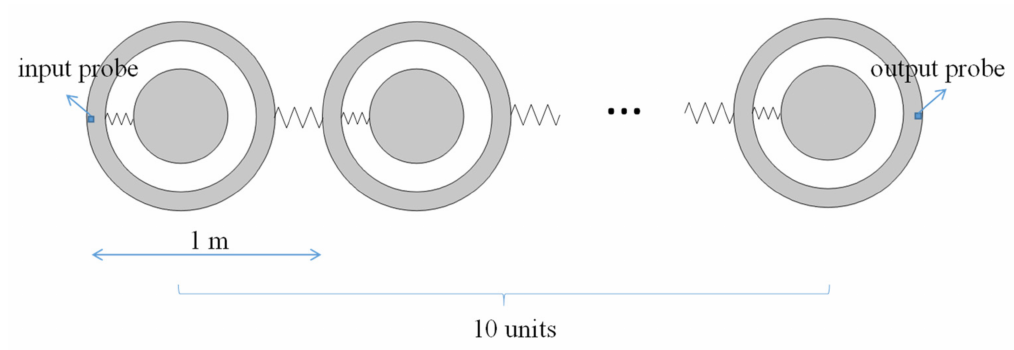
Figure 6. Schematic diagram of the mass-in-mass phononic crystal using the multi-body dynamics module in COMSOL Multiphysics. The inner mass is m 1 = 0.2 kg with k 1 = 2 × 10 5 N/m attached to the outer mass m 0 = 0.1 kg. The spring connecting each unit is k 0 = 1 × 10 5 N/m.